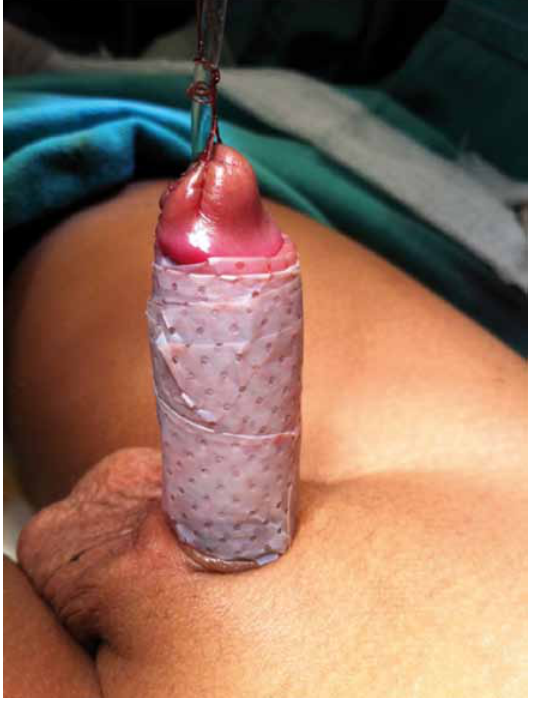
Figure 1 - Polyurethane pellicle molded to the penile shaft. Figure 2 - Biopolymer pellicle made of sugarcane molded to the penile